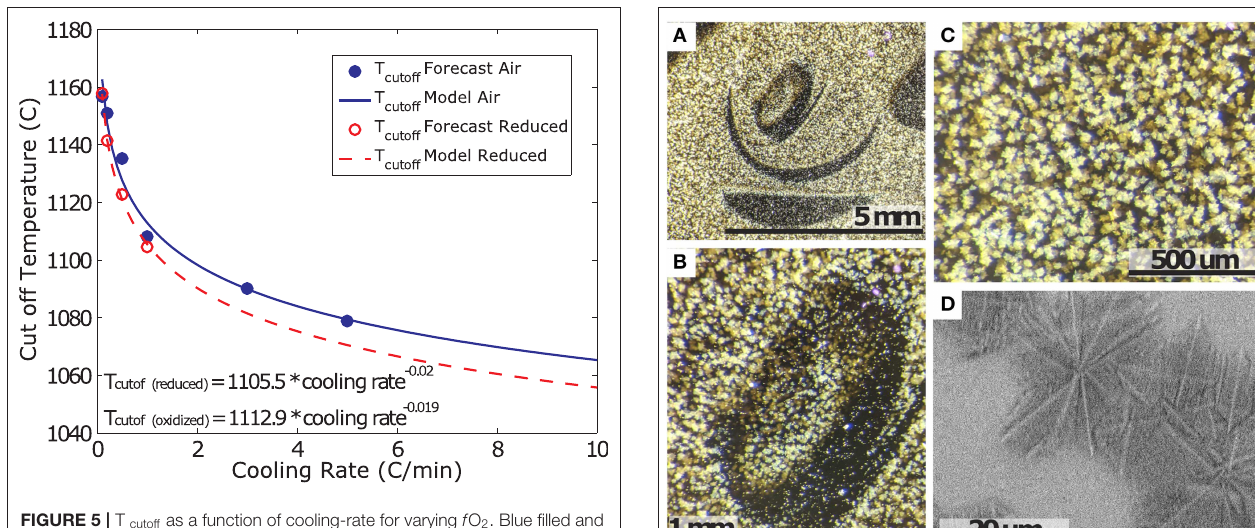
FIGURE 5 | T cutoff as a function of cooling-rate for varying f O 2 . Blue filled and red open circles represent the forecasted values for oxidizing and reducing conditions, respectively. The blue solid and red dashed lines represent the power law model fitted to these data describing T cutoff as a function of cooling rate for oxidizing and reducing conditions, respectively.